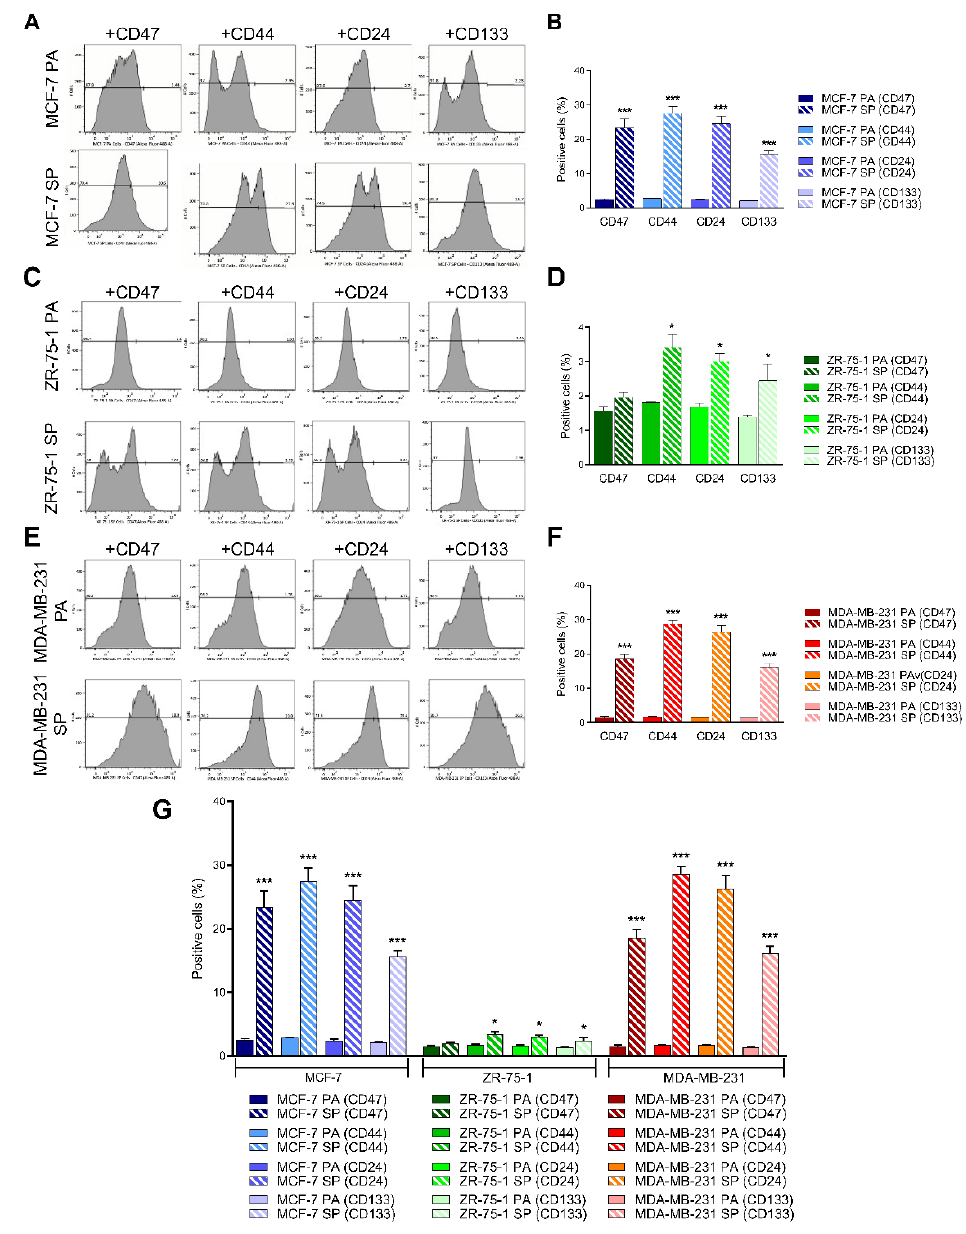
Figure 5. FACS analysis of stem cell markers expression on breast cancer monolayers and 3rd generation spheroids. FACS analysis of ( A , B ) MCF-7, ( C , D ) ZR-75-1, and ( E , F ) MDA-MB-231 monolayer (PA) and 3rd generation spheroids (SP) for CD47, CD44, CD24, and CD133. Adherent monolayer cells and spheroids were incubated overnight at 4 ◦ C with primary antibodies against CD47 (1:100), CD44 (1:30), CD24 (0.25 µ g per 106 cells/100 µ L), or CD133 (1:300). Cells were washed three times with PBS and incubated with the appropriate secondary antibody (1 µ g per 10 6 cells) for 1 h at room temperature. Cells were washed and analyzed on a BD FACSCAN flow cytometer. ( G ) Comparison of the number of positive cells for MCF-7, ZR-75-1, and MDA-MB-231 PA and SP. Data from FACS analysis assay representative of stem cell marker expression was quantified for comparison between PA and SP for all three cell lines ± SEM of three independent experiments performed in triplicates by unpaired two-tailed t -test at 95% confidence. * p ≤ 0.05, *** p ≤ 0.001, n = 3. Abbreviations: PA, parental; SP, spheroid; PBS, phosphate-buffered saline; CD, cluster of differentiation.